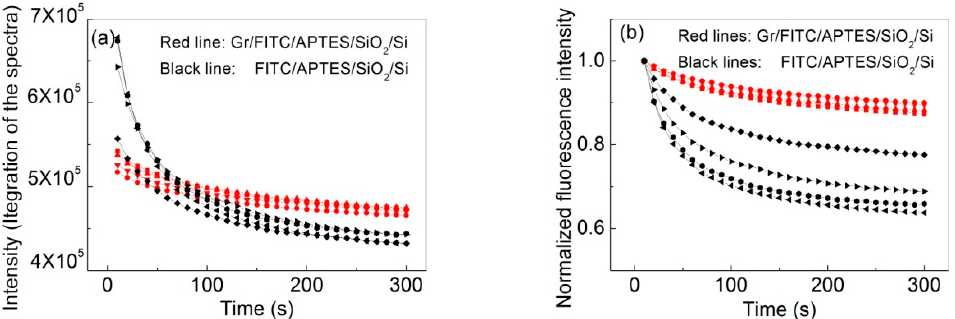
Figure 4. The photo-bleaching curve of FITC dye contacted with graphene (red) and without graphene (black). The intensity was calculated by integration from 583 to 2411 cm − 1 ( a ) and normalized by the maximum value ( b ). Each curve represents a separate kinetic measurement on a different location of the same sample. Each spectrum was integrated for 5 s and measured every 10 s over a period of 5 min.